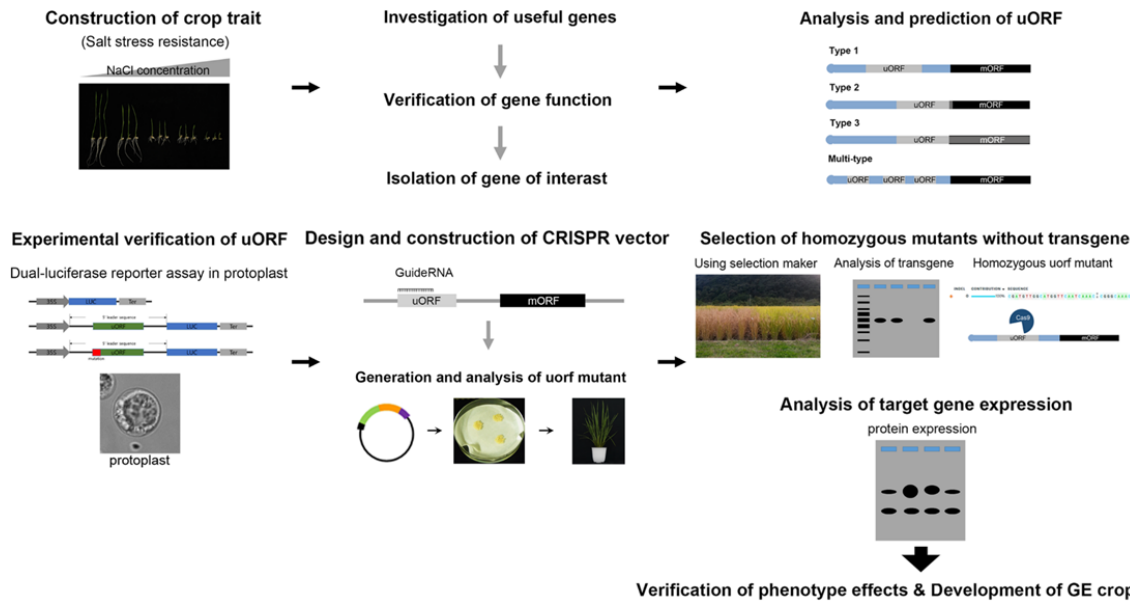
Figure 4. Overview of the process of gene editing of uORFs with the CRISPR system for the development of GE crops.